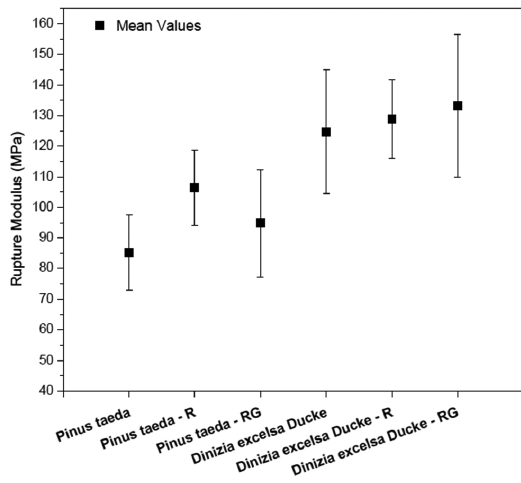
Figure 7. Rupture modulus from samples: in natural state, coated with resin (R) and coated with resin and geotextile fiber (RG). Table 1. Modulus of elasticity and modulus of rupture of uncoated and coated samples cut from random wood pieces. Wood